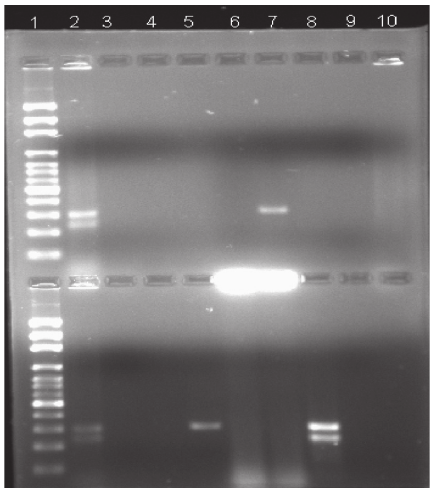
Figure 1: PCR amplification results with phoP and Hin primers pairs. Upper panel: lane 1: 100 bp molecular weight marker, lane 2: (++)- S. enterica ATCC 13076, lane 7: (+) (isolate 6), and lane 10: negative control (no template). Lower panel: lane 1: 100bp molecular weight marker, lane 2:(++)- S. enterica ATCC 13076, lane 5: (+) isolate 7, and lane 8 (++): isolate